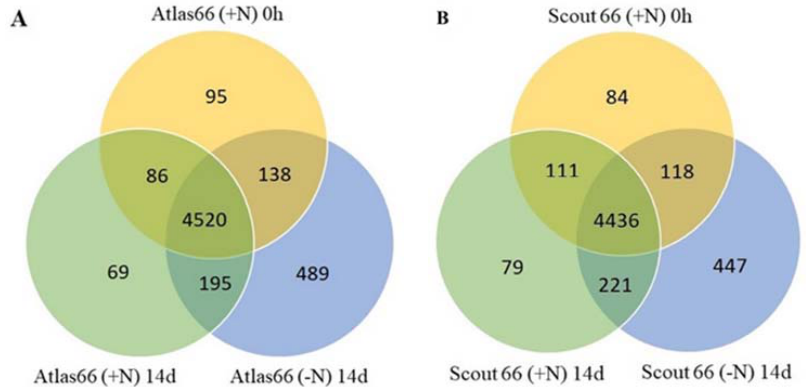
Figure 7. Venn diagram of total proteins identified in the leaves of Atlas 66 and Scout 66 in this study. The Venn diagram showed the total number of proteins identified among three conditions in both Atlas 66 ( A ) and Scout 66 ( B ).